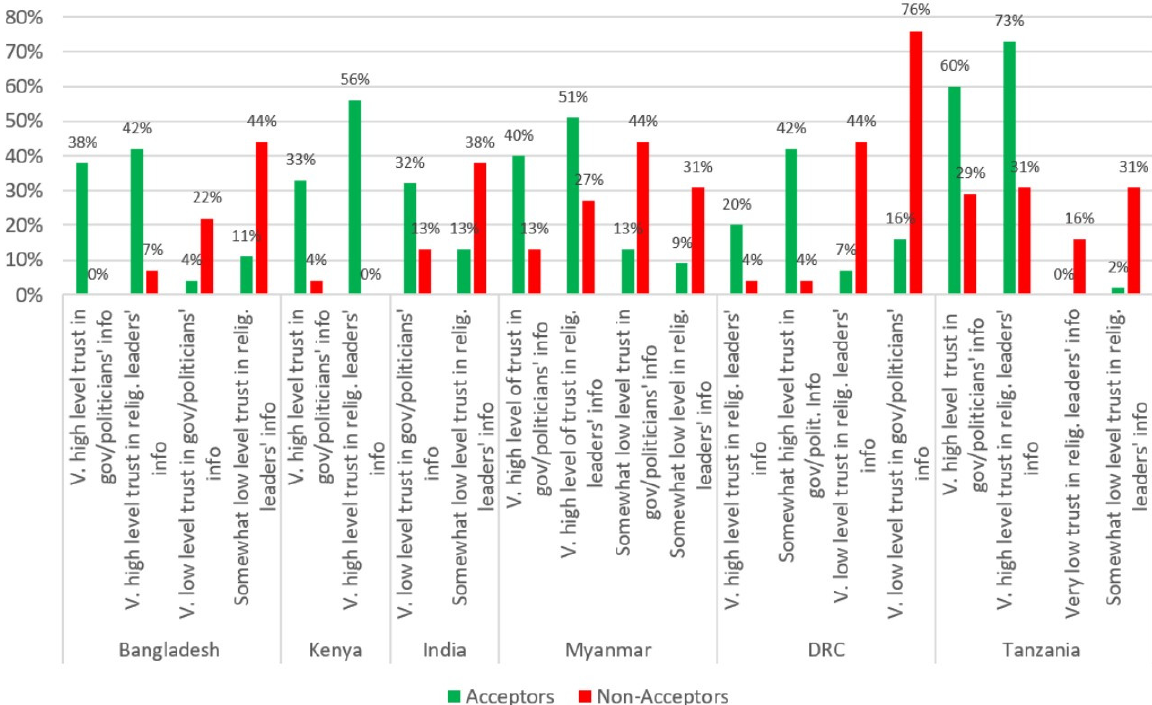
Figure 5. Acceptors’ and Non-acceptors’ trust level in COVID-19 safety and effectiveness information by source of information.